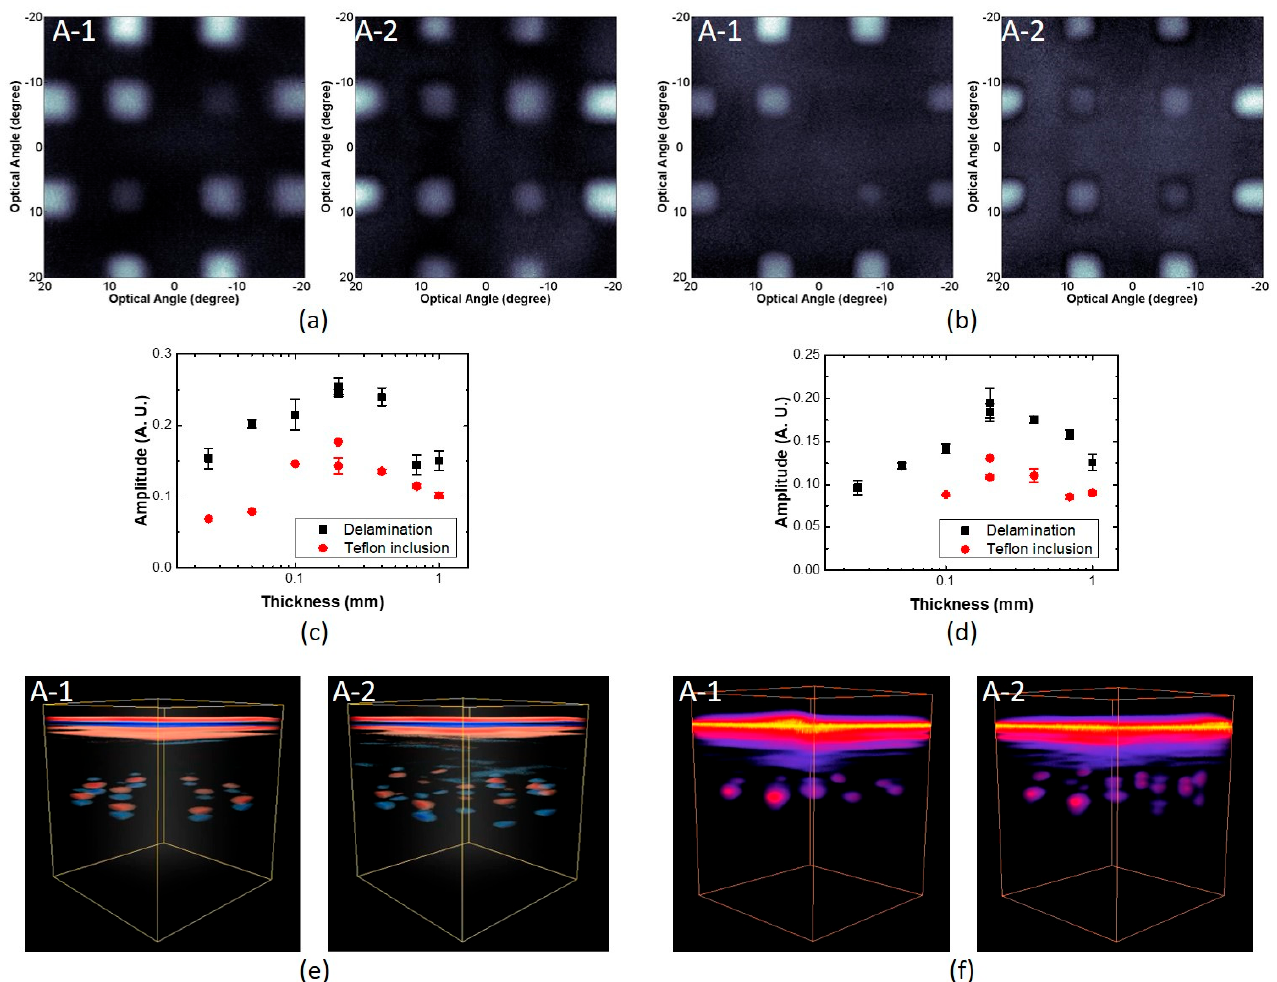
Figure 4. ( a ) C-scan images, ( c ) THz signal amplitude versus defect thickness, and ( e ) 3D images of samples A-1 and A-2 obtained using the time-domain THz tomography system. ( b ) C-scan images, ( d ) THz signal amplitude versus defect thickness, and ( f ) 3D images of samples A-1 and A-2 obtained using the frequency-domain THz tomography system.